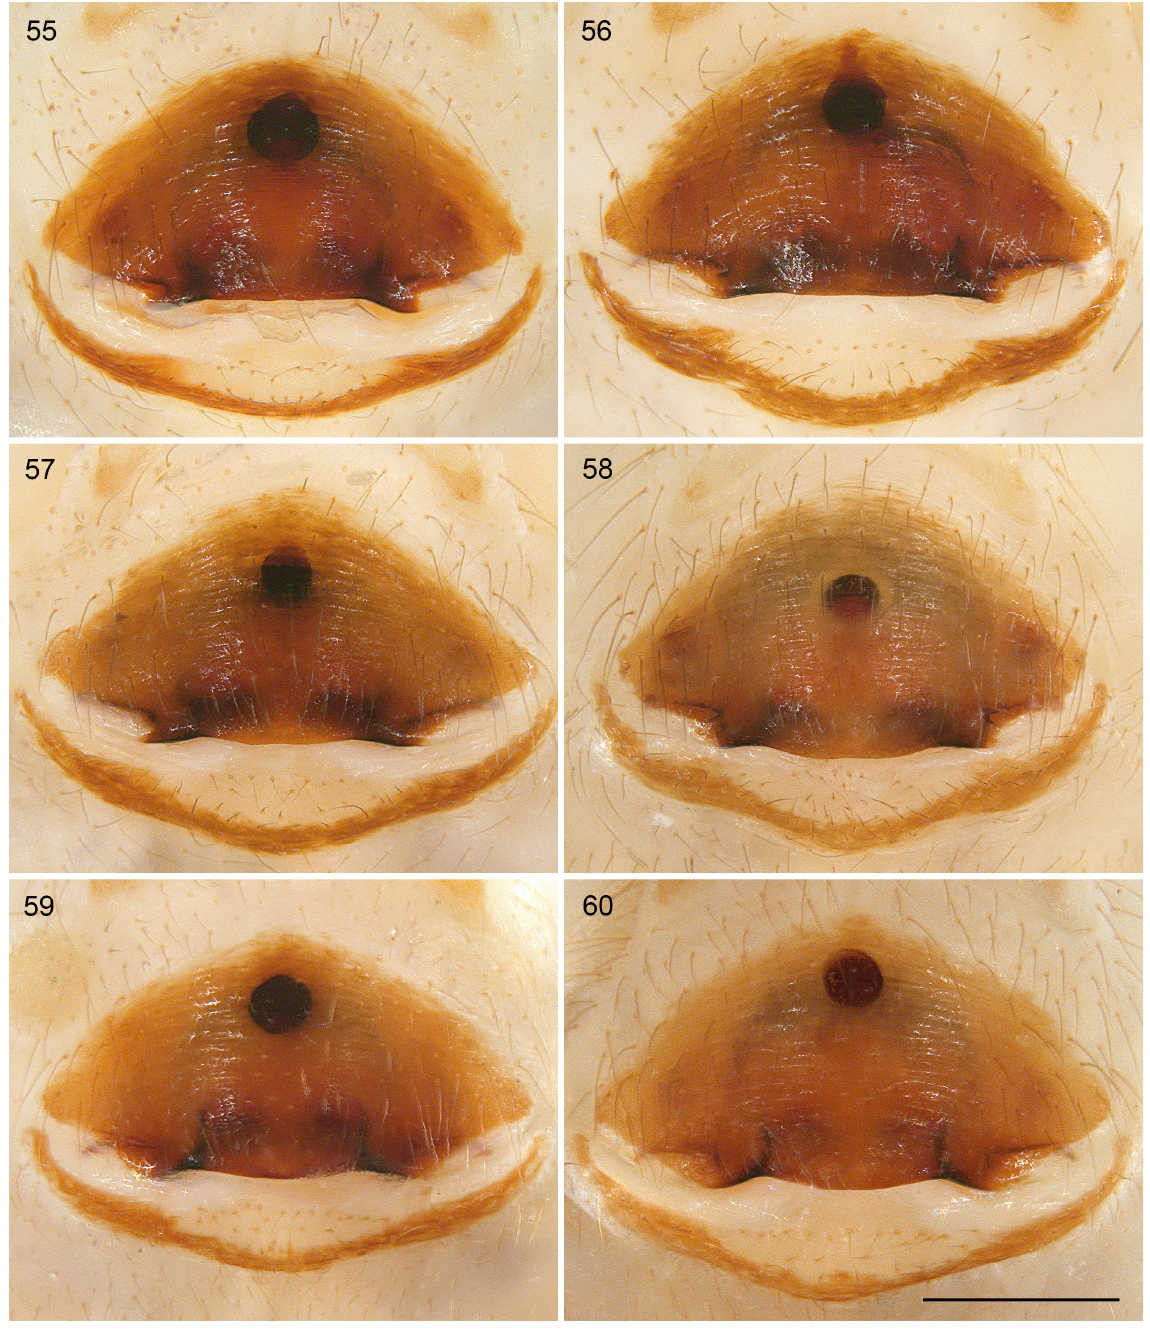
Figs 55–60. Stygopholcus skotophilus Kratochvíl, 1940; epigyna, ventral views. 55–56 . Pećina u Ivici, Montenegro (ZFMK (Ar 22196)). 57 . Ilijina pećina, Bosnia and Herzegovina (ZFMK (Ar 22198)). 58 . Studena pećina, Bosnia and Herzegovina (CMK). 59–60 . Specimens assigned tentatively from Grabova pećina, Sedlari, Bosnia and Herzegovina (MHNG). Scale bar: 0.5 mm (all at same